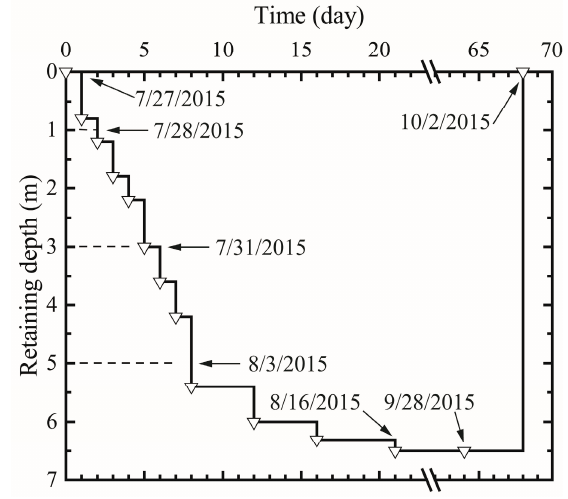
Figure 6. The schedule of the construction progress.